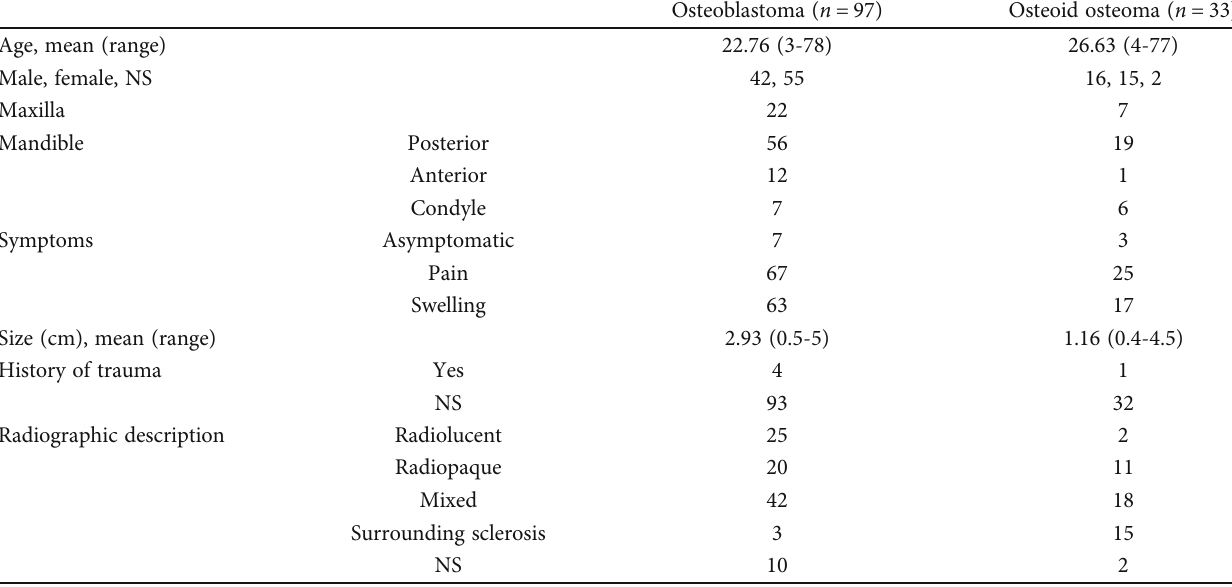
Table 4: Summary of all reported cases of osteoblastoma and osteoid osteoma of the maxilla and mandible, including current